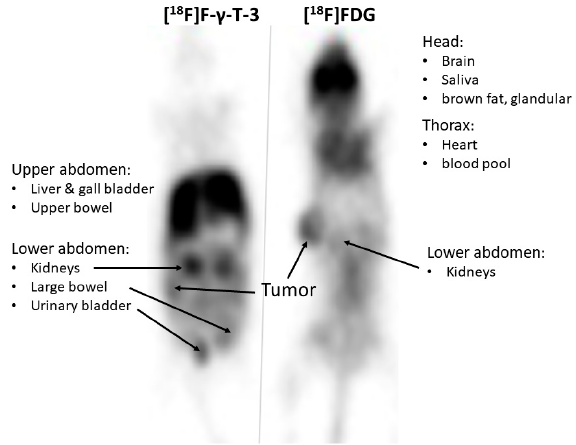
Figure 4. F-18 PET images showing the biodistribution of radioactivity in a mouse following i.v. tail veil injections of [ 18 F]F- γ -T-3 (left image) and reference [ 18 F]FDG (right image). The [ 18 F]F- γ -T-3 image was captured 2 h after injection, and the [ 18 F]FDG was obtained 90 min post-injection, using the same animal 24 h following the [ 18 F]F- γ -T-3 study.